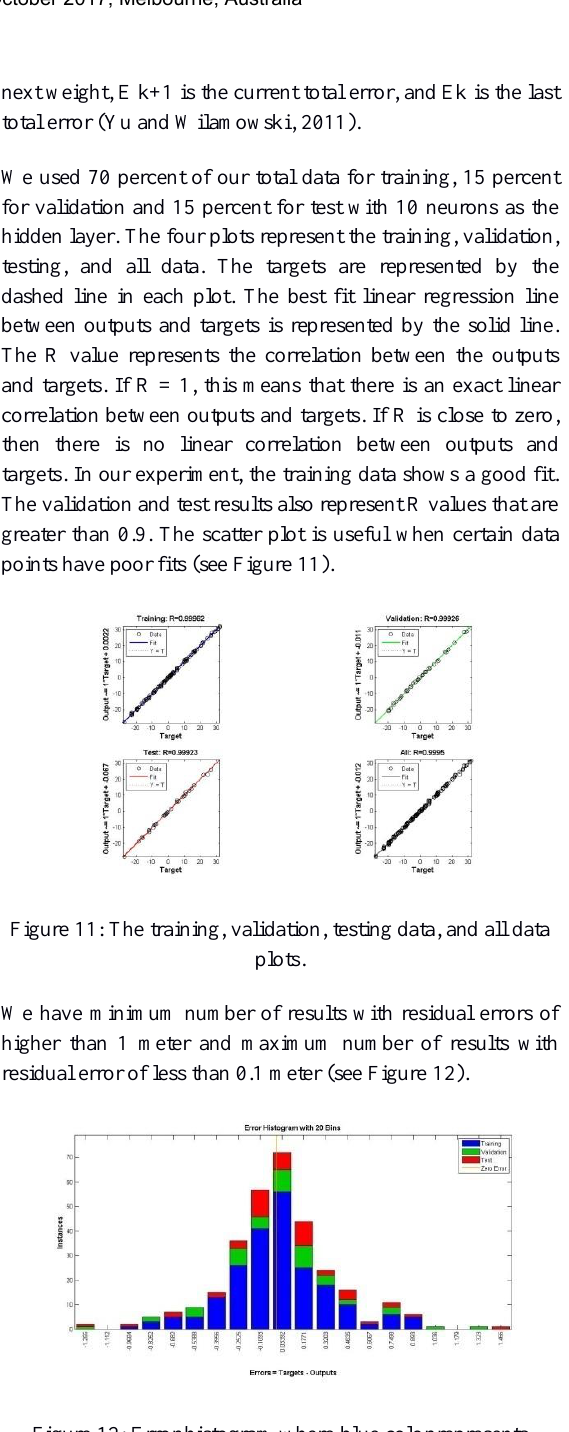
Figure 12: Error histogram where blue color represents training data, green color represents validation data and red color represents test